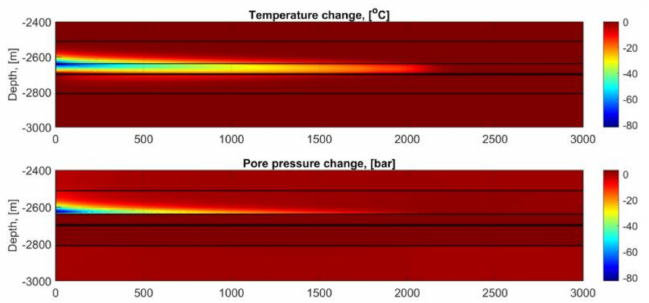
Figure 9. Temperature and pore pressure state after 50 years. ( Top ) temperature change, ( bottom ) pore pressure change.